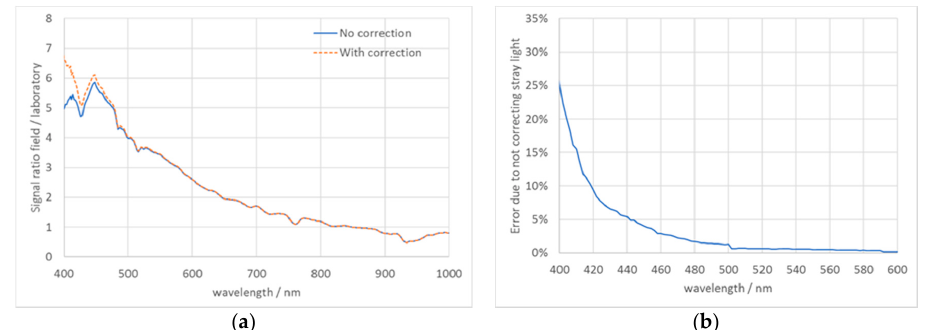
Figure A5. ( a ) Ratio of the signal between the field measurement and the laboratory calibration with and without stray light correction. ( b ) Error introduced if the stray light is not corrected (this is the ratio of the two lines in the left-hand graph).